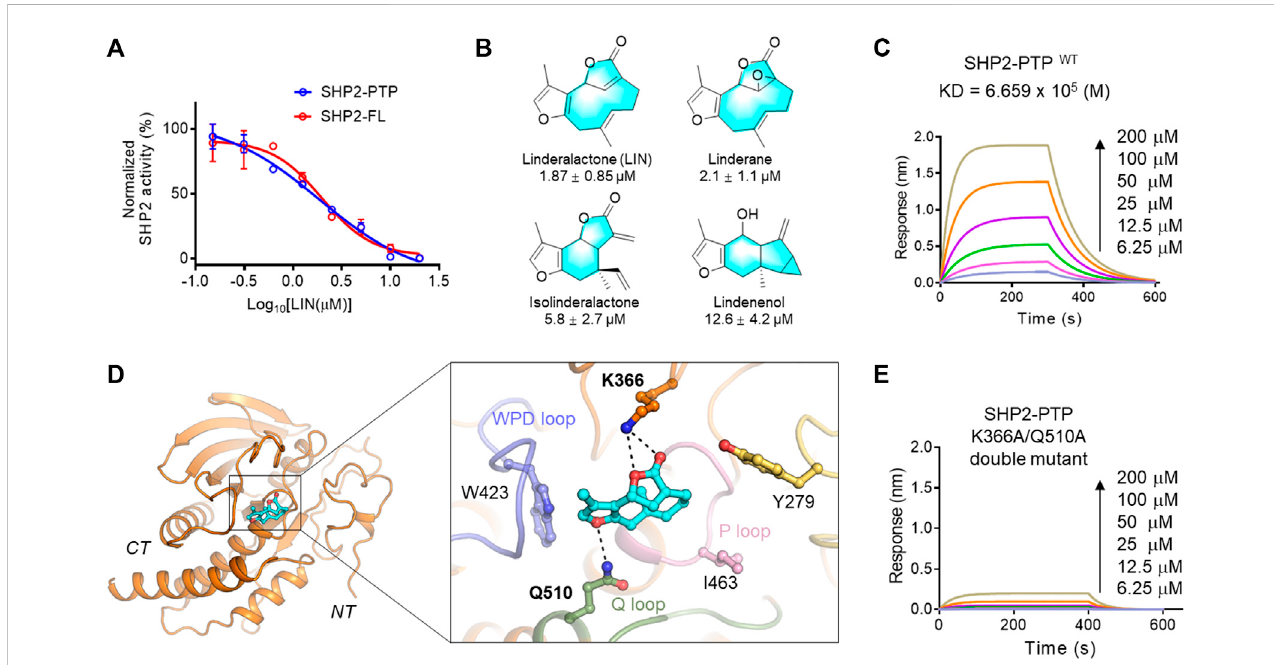
FIGURE 2 ValidationofLINderivatives asSHP2-PTP inhibitors. (A) IC 50 ofLINontheenzymeactivityofthefulllength(redline,SHP2-FL)andcatalytic domain(blue line) of SHP2. Note that LIN showed a similar inhibition effect on SHP2-PTP and SHP2-FL enzymes with half-maximum inhibitory concentration (IC 50 ) values at 1.87 and 1.98 μ M, respectively. For full-length SHP2 assay, activating peptide p-IRS-1 was supplemented to active SHP2. (B) The chemical structures of LIN derivativesalongwiththeSHP2-PTPIC 50 values. (C) Abio-layerinterferometry(BLI)assayevaluatingthebindingaf fi nityofLINtowildtypeSHP2-PTP. (D) Binding mode analysis of LIN to SHP2 catalytic domain (PDB ID: 4RDD). (E) Binding af fi nity analysis of LIN to the SHP2 K366A/Q510A double